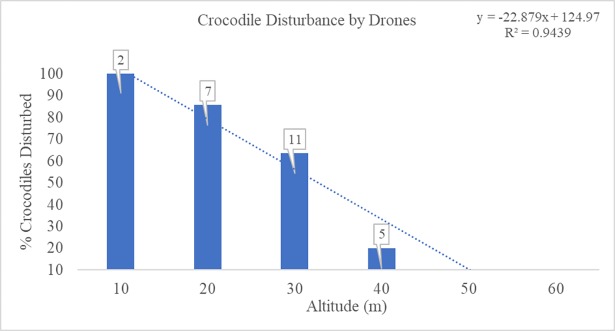
Crocodiles disturbed by a drone at various altitudes.Percentage of crocodiles (Crocodylus posorus) observed during drone-based surveys Bare Sand Island, Northern Territory, and Cape Domett, Western Australia, that were disturbed by the presence of a drone at various altitudes. Results are based on a total of 31 crocodile sightings over 10 surveys observed either resting on the beach, in the surf, or actively swimming on the surface of nearshore waters between the surf and approximately 300 m off the nesting beach. The numbers of total crocodiles sampled for each altitude are show in boxes above the bars.